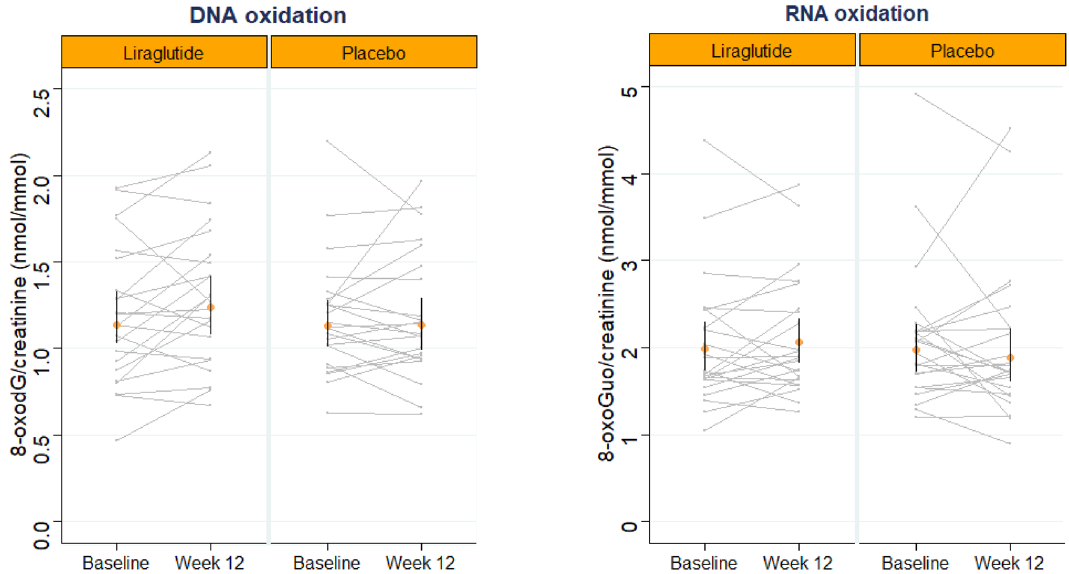
Figure 2. The LIRALBU study: GG-plot demonstrating individual effects after 12 weeks of liraglutide or placebo treatment in urinary excretion of 8-oxo-7,8-dihydroguanosine (8-oxoGuo) and 8-oxo-7,8-dihydro-2 ′ - deoxyguanosine (8-oxodG). Geometric mean with 95% confidence interval limits is